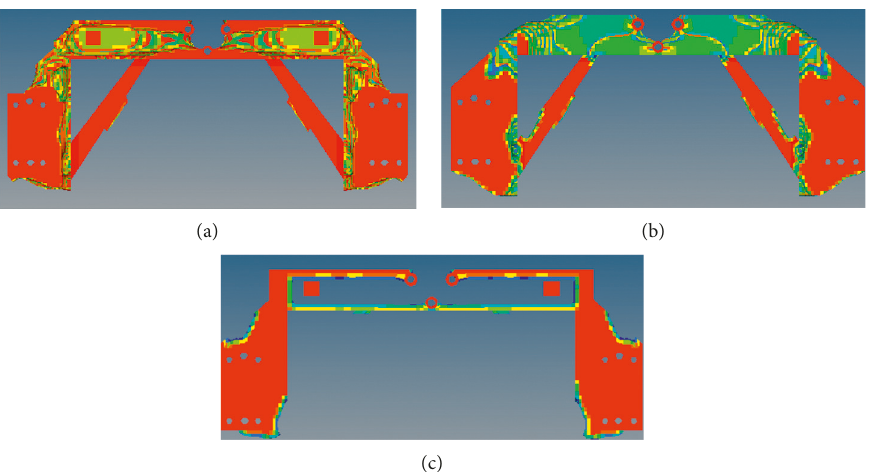
Figure 4: Static load topology optimization results. (a) Topology optimization results of latch limit tension load; (b) topology optimization results of pedestrian protection impact load; and (c) topology optimization results of cushion area load.